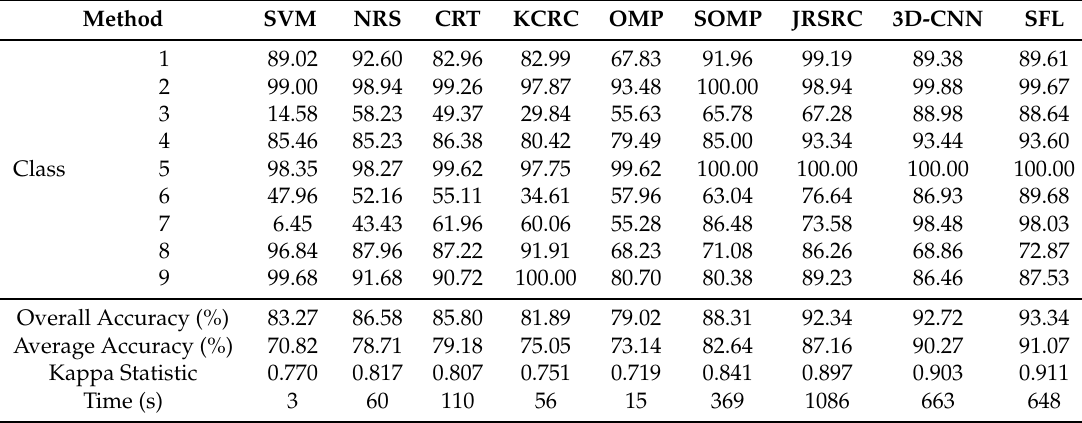
Table 8. Overall Accuracy, Average Accuracy, Kappa Statistic and Time of the Pavia University data set when using the compared methods and the proposed